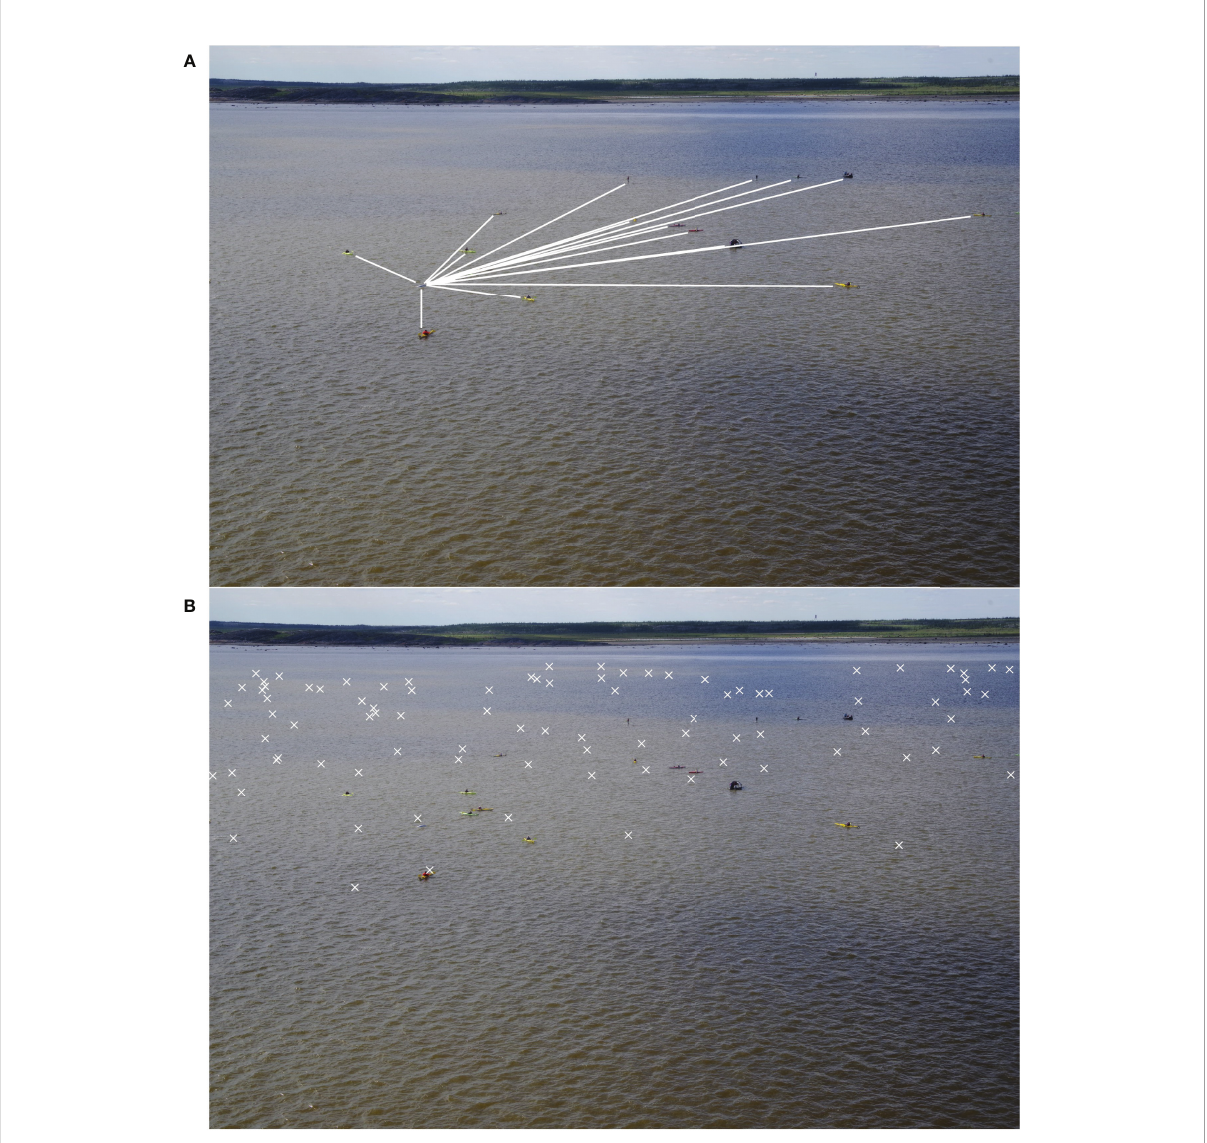
FIGURE 6 (A) Distances for Monte Carlo analysis collected between belugas and all vessels in a photo (white lines). (B) An example of 100 expected locations (white x), of which the distance between each point and all vessels is used to determine the expected